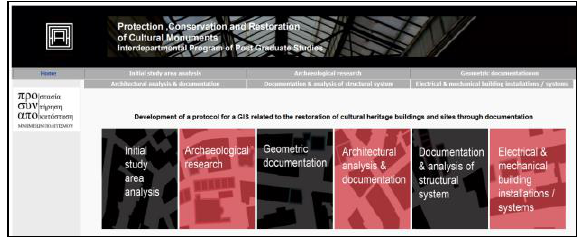
Figure 8 . Layout of the multimedia application (presentation of work stages).